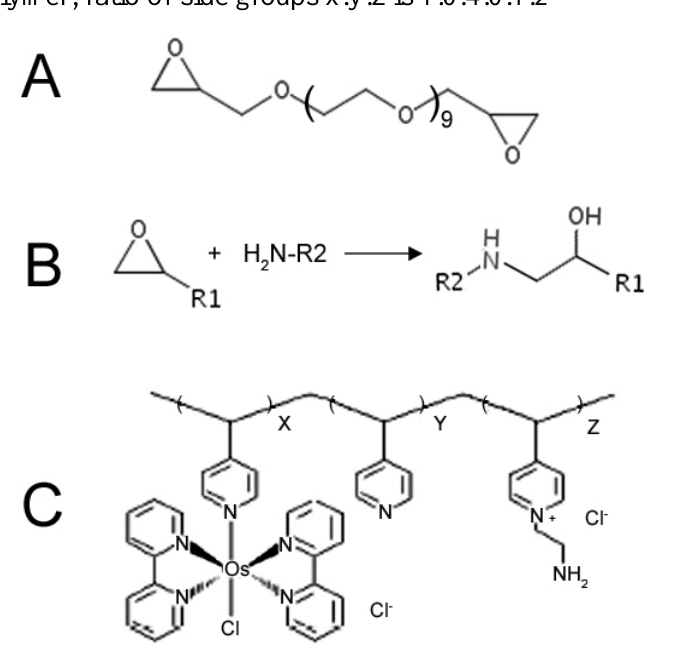
Figure 4. Compositions of the hydrogel-coated glutamate microsensor. (A) Poly(ethylene glycol) diglycidylether (PEDGE), the cross-linker that connects the enzymes to the osmium redox polymer. (B) Cross-link reaction between enzymes (protein) and PEDGE. (C) Osmium redox polymer; ratio of side groups x:y:z is